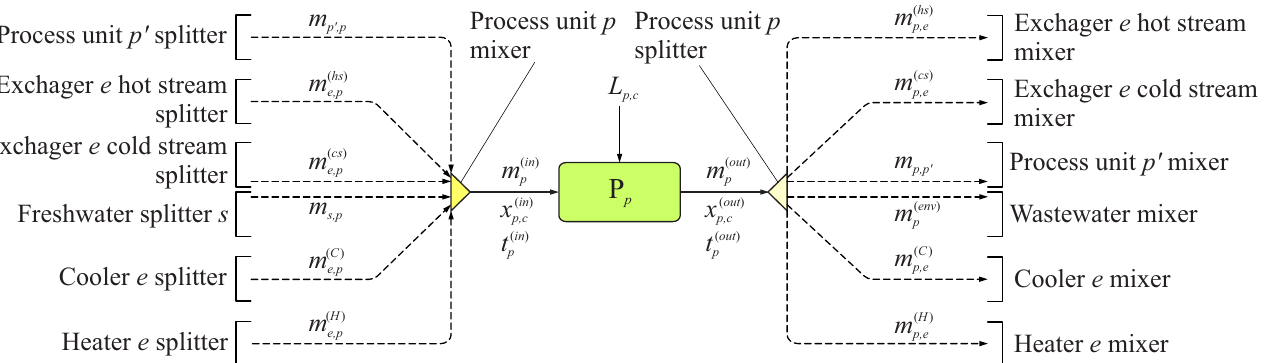
Figure 6. Process water-using unit with corresponding streams.